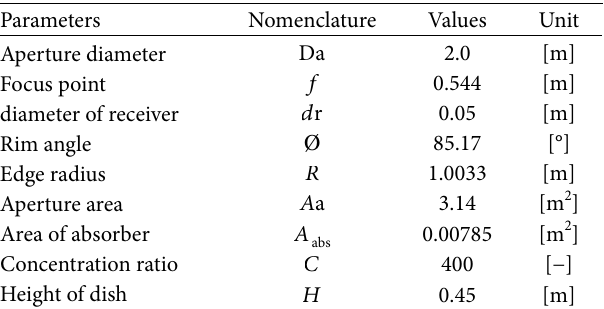
Figure 3: Geometry and dimension of the solar collector parabolic dish. Table 1: The results of parameters and dimensions of parabolic so- lar collector.